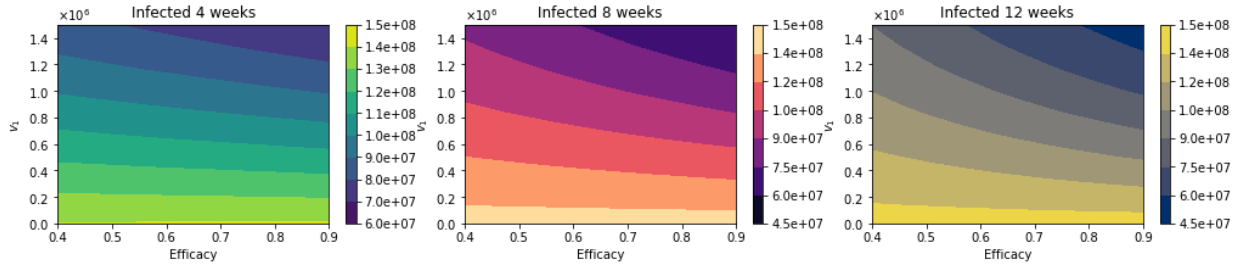
Figure 12. Total number of infected people for a variety of vaccine efficacies after the first dose and different vaccination rates per day. The basic reproduction number R 0 > 1. Assuming that the percentage of infections that are asymptomatic is just 15% [113].